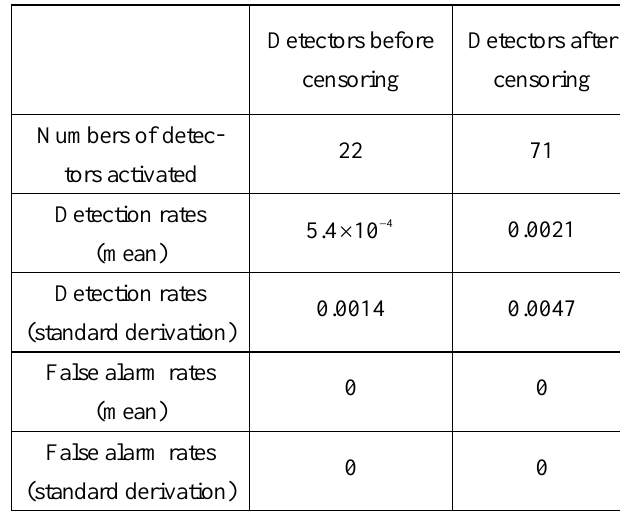
Table 3. Bearings ball damage fault detection performances of detectors before and after censoring.